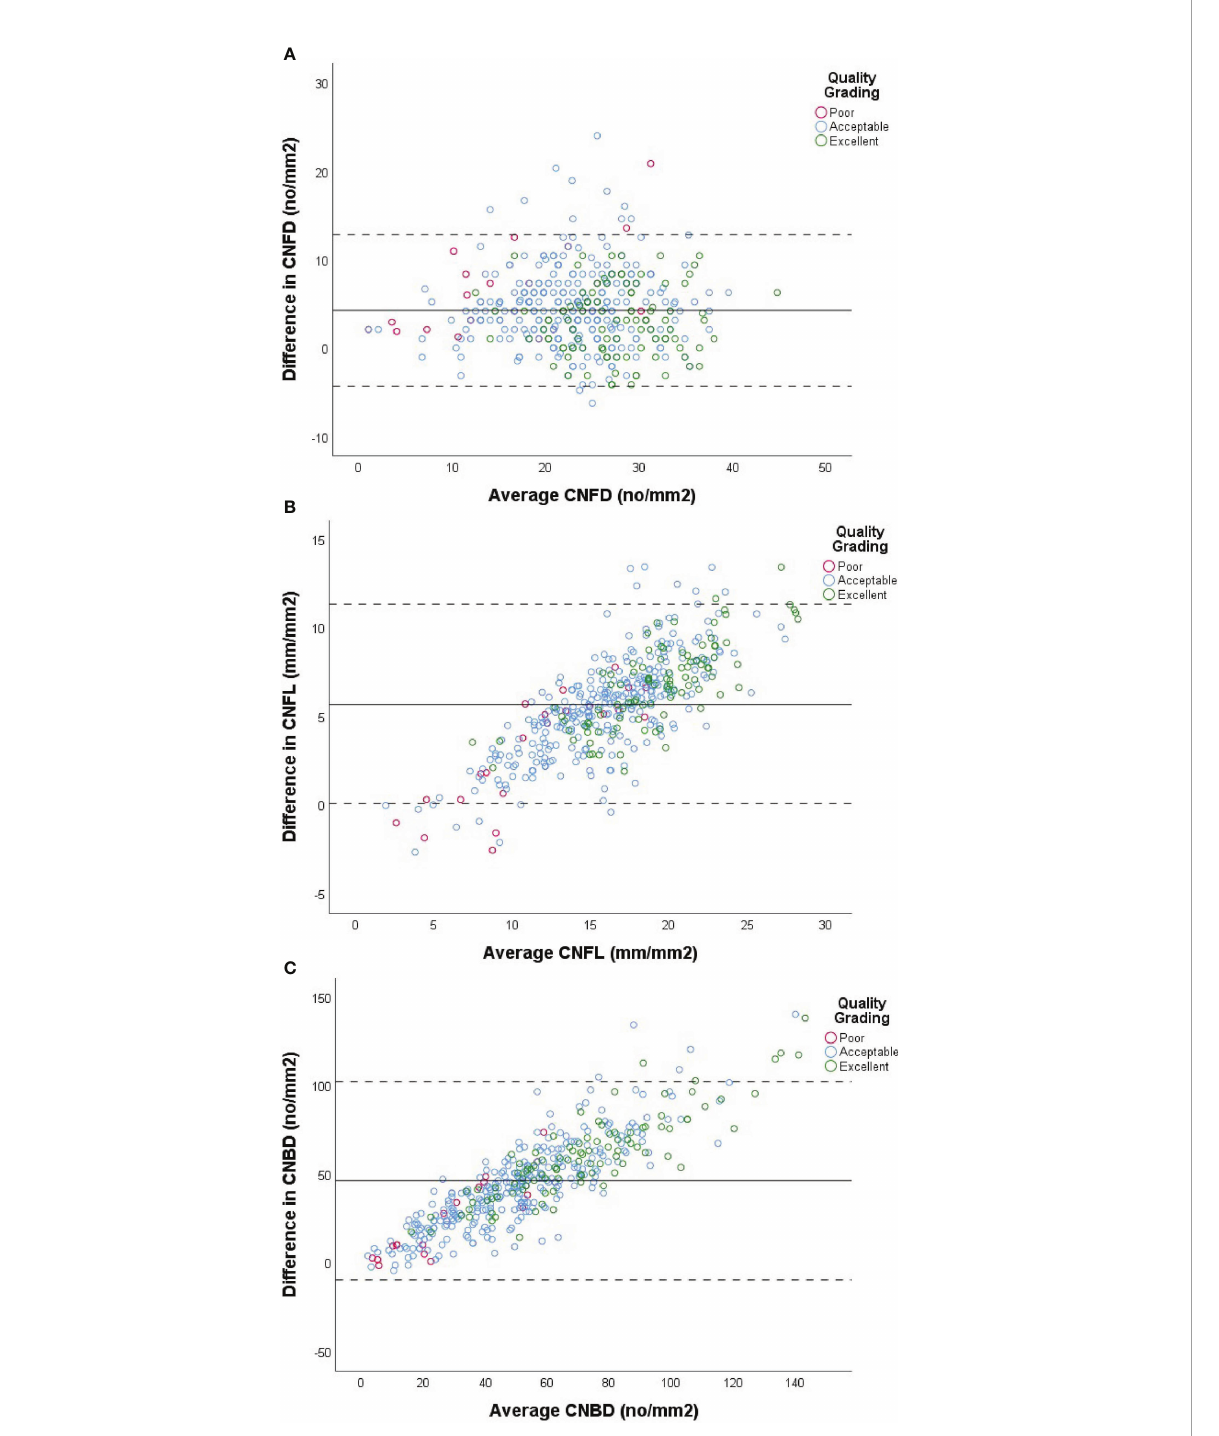
FIGURE 2 Comparison of automated vs semi-automated analysis of CNFD (A) , CNFL (B) and CNBD (C) using Bland-Altman plots. X-axis of each plot represents the mean measurement between the two methods of analysis for each subject. Y-axis represents the difference in values between the two methods for each subject, calculated by (semi-automated value - automated value) for each patient. Data from cohort with diabetes used in analysis (n=427). Solid line represents the mean difference between the two methods. Dashed lines represent +/- (1.96 x 2SD). Red, blue and green markers represent images graded as poor, acceptable and excellent by the investigator,